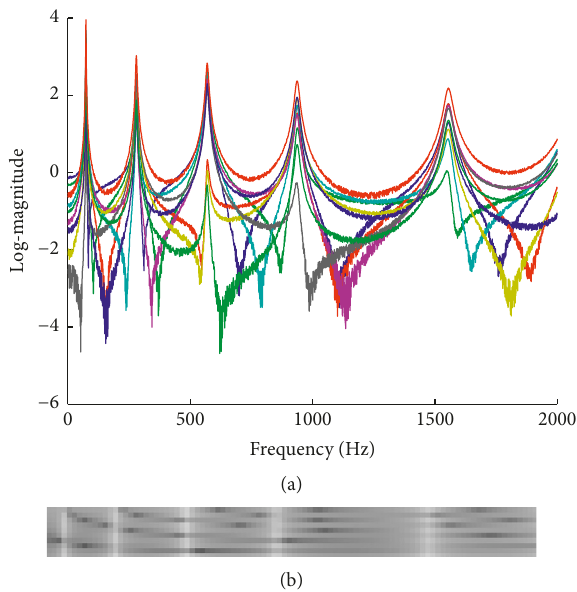
Figure 5: Ten TFs measured in a structural beam (a) and the image representation of the TFs used as input by the CNN